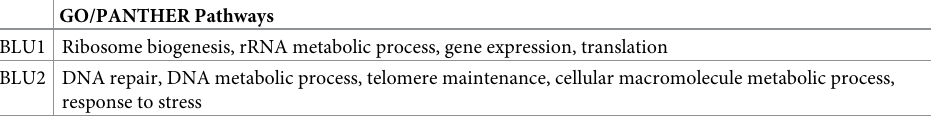
Table 4. The two gene sets (BLU1, BLU2) that do not interact with the three major clusters Chemokine-CLU, IFU-CLU, and IL-CLU. GO/PANTHER Pathways